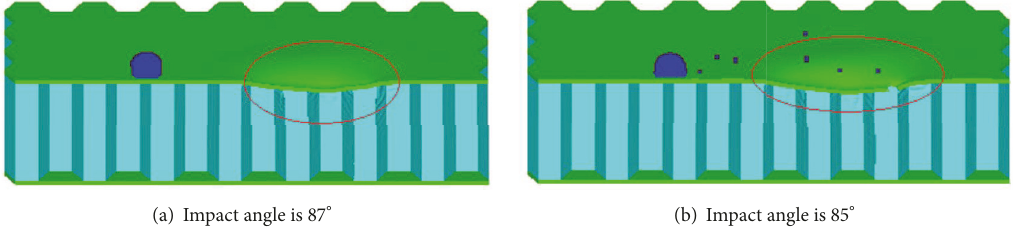
Figure 8: Critical penetration of the front face sheet.